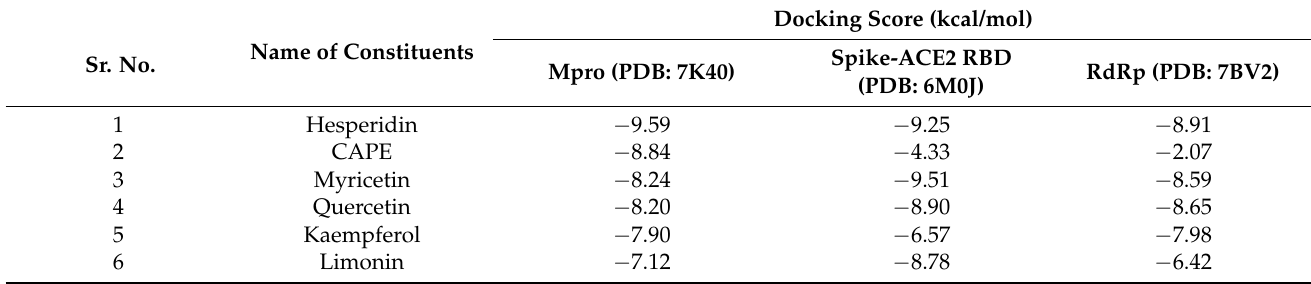
Table 1. In silico anti-SARS-CoV-2 potential of propolis constituents.